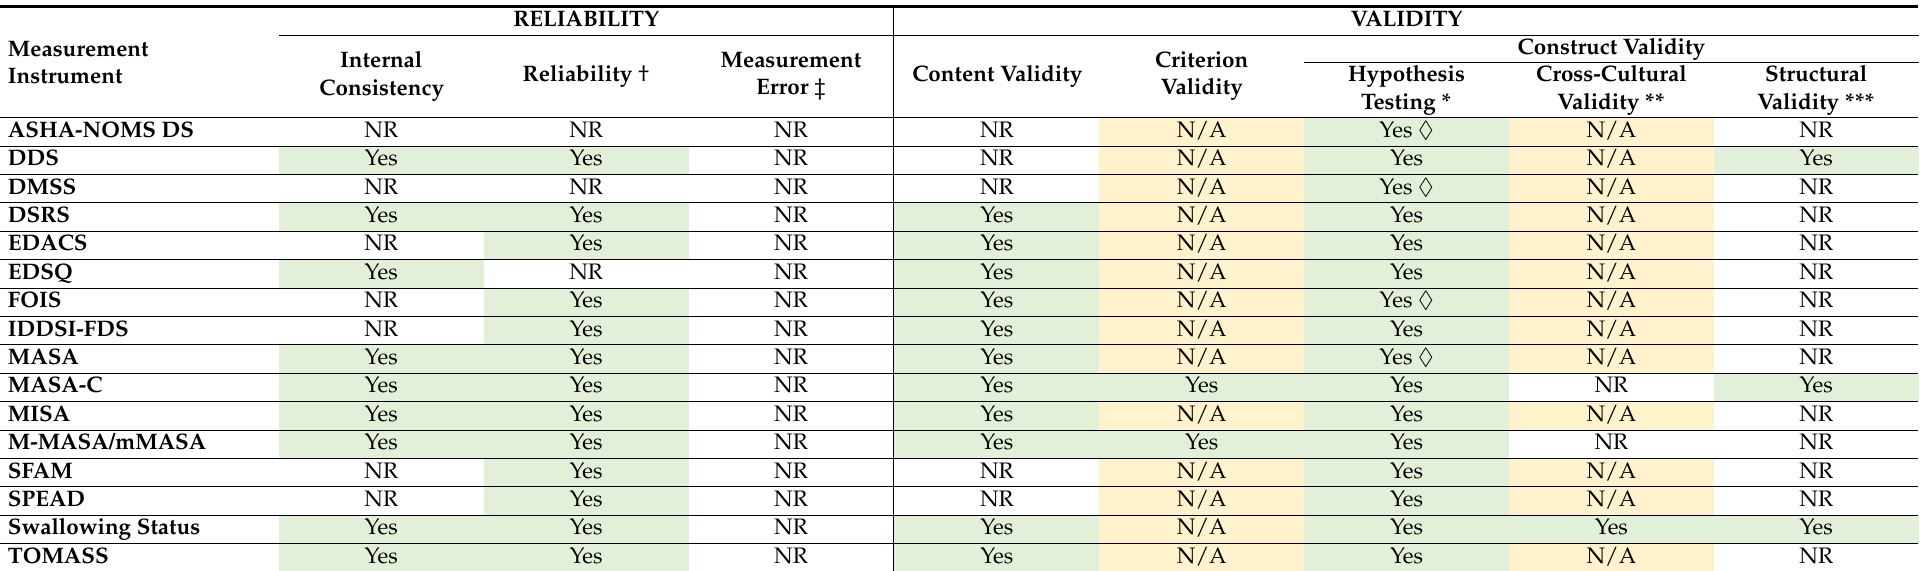
Table 4. Summary of measurement properties evaluated for each